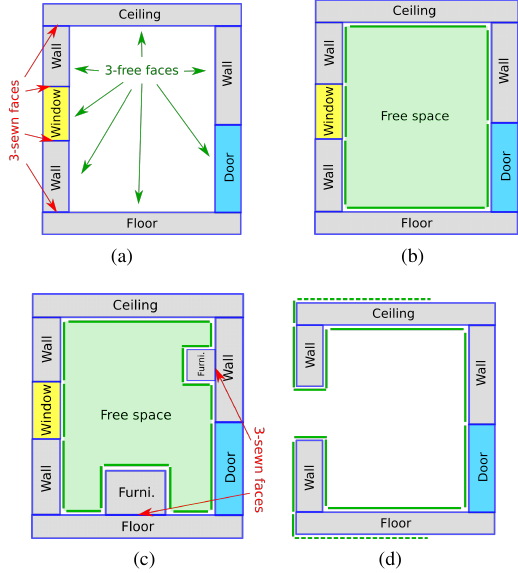
Figure 10: 2D projection of a free space volume reconstruction based on the approach of (Diakit´e et al., 2014a). (a) The faces that are not involved in a 3 -sew operation among the model are de- tected. (b) Those faces are duplicated and 2 -sewn between them to form a new volume corresponding to the free space. (c)